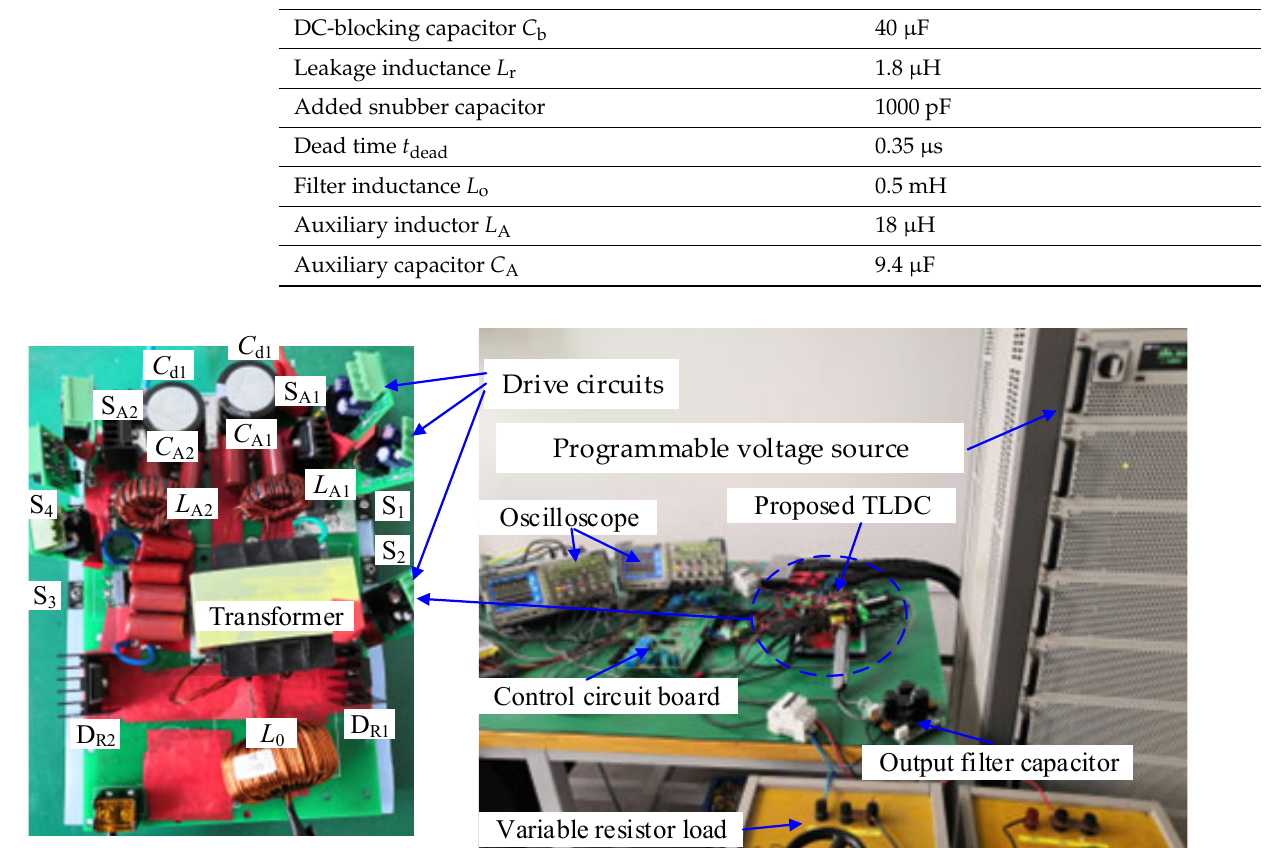
Figure 8. A photograph of the experimental platform.